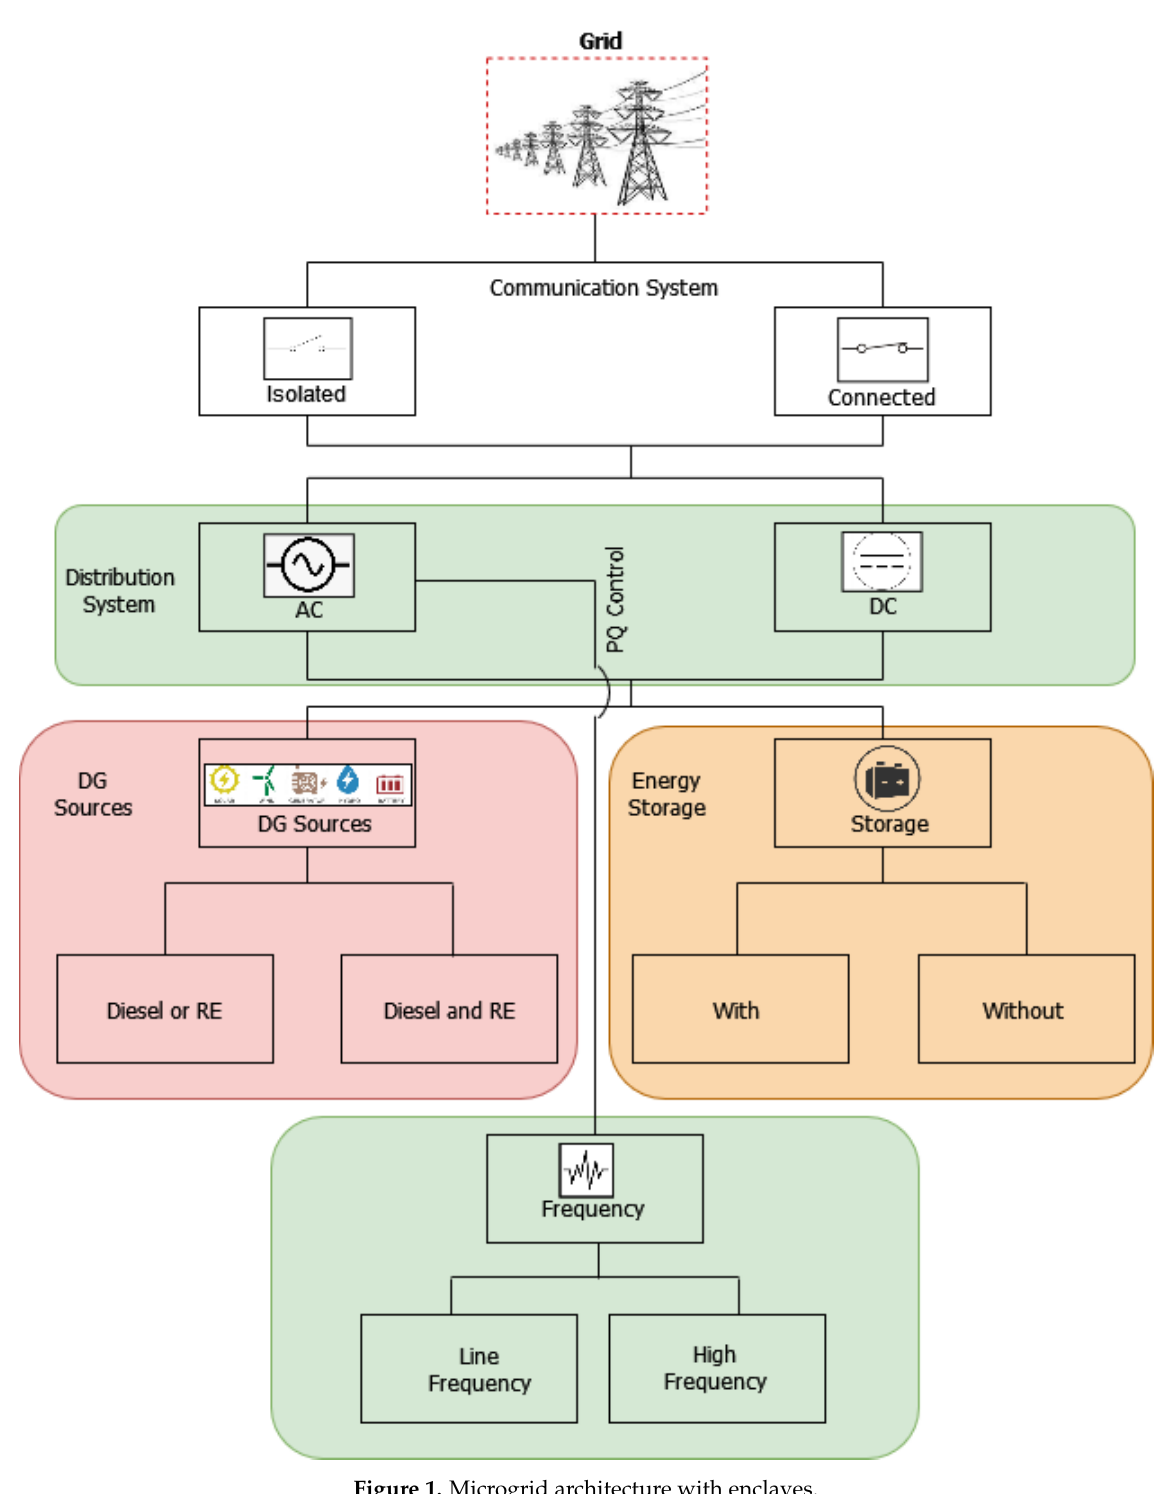
Figure 1. Microgrid architecture with